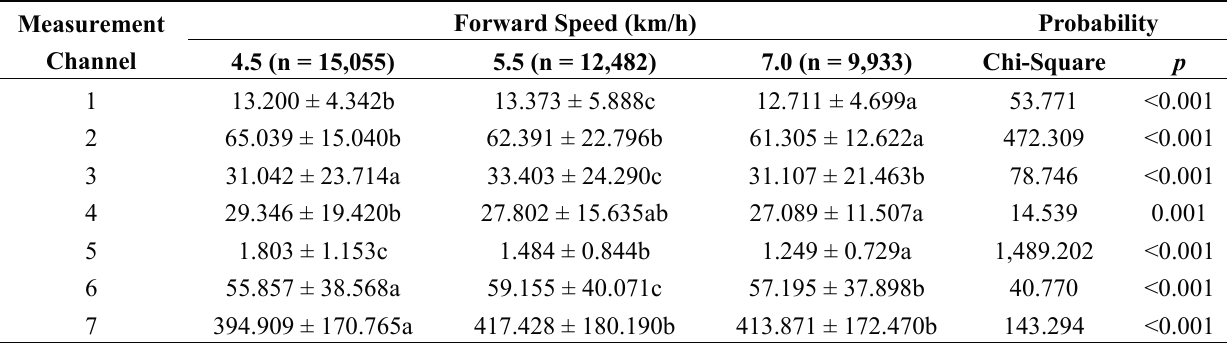
Table 6. Average micro-strains ( με ) measured by gauges at different forward speeds. One-way ANOVA: forward speed (km/h). Mean differences tested with the Kruskal-Wallis test. Different letters indicate significant differences ( p < 0.05) obtained through the Mann-Whitney U-test for a specific measurement channel considering different forward speeds. Measurement